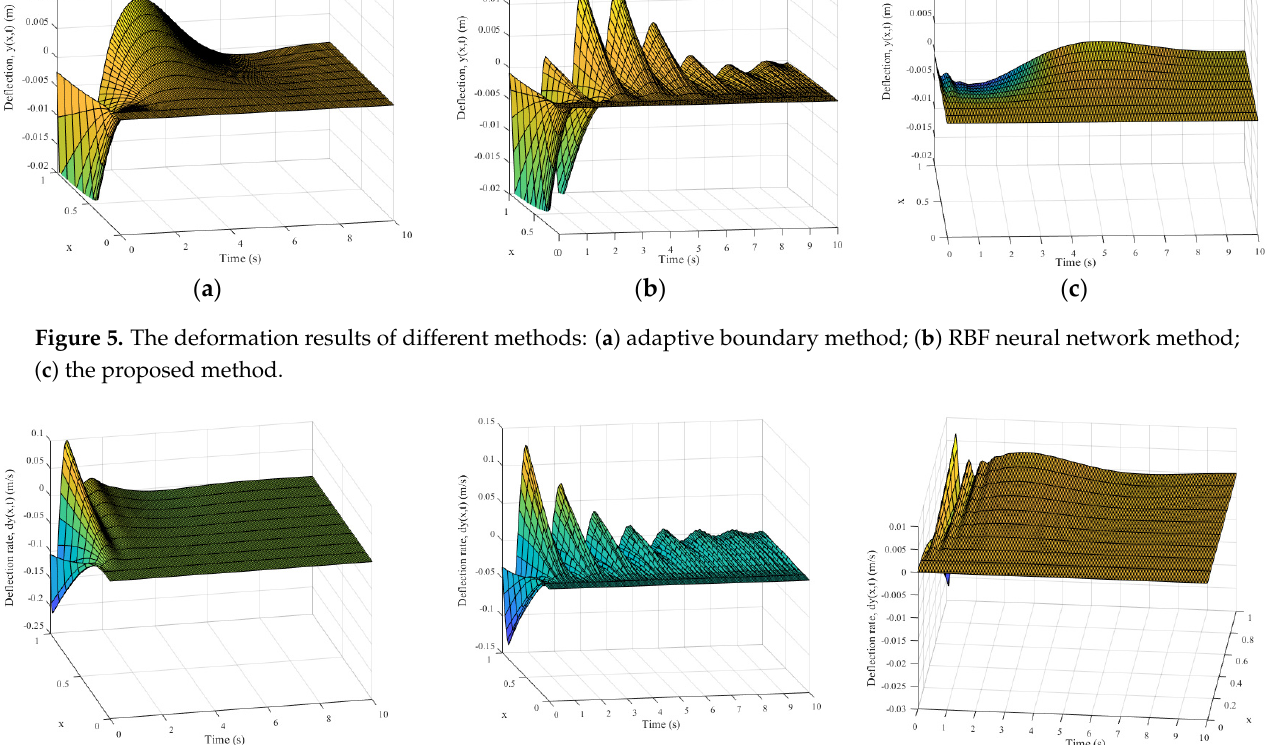
Table 2. The statistical results of the simulation data of the proposed method and the comparison